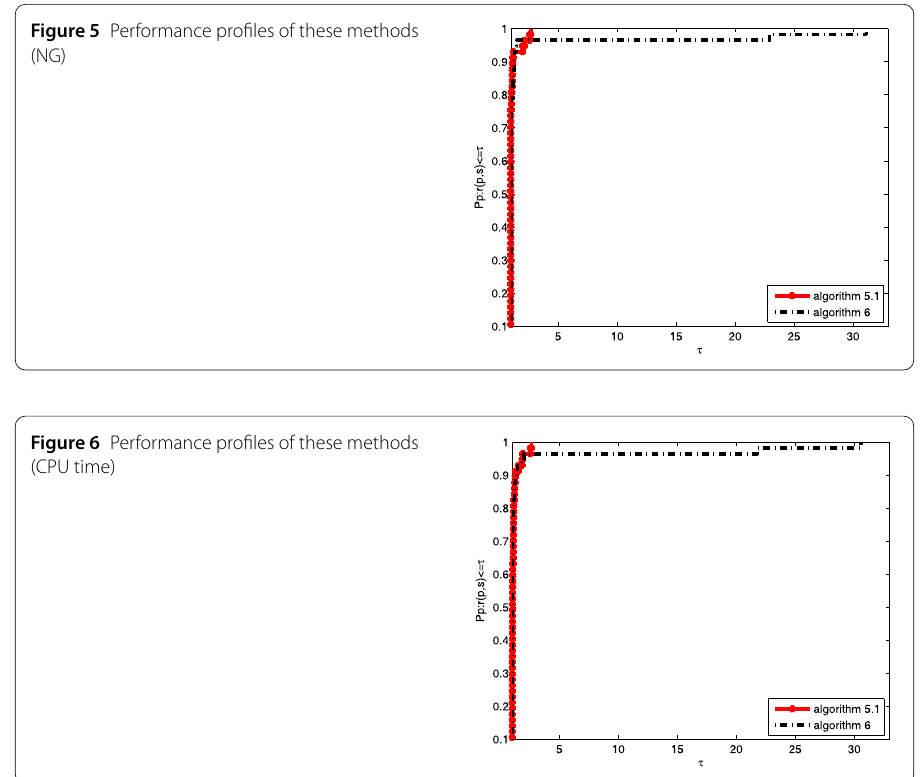
Figure 5 Performance profiles of these methods (NG)